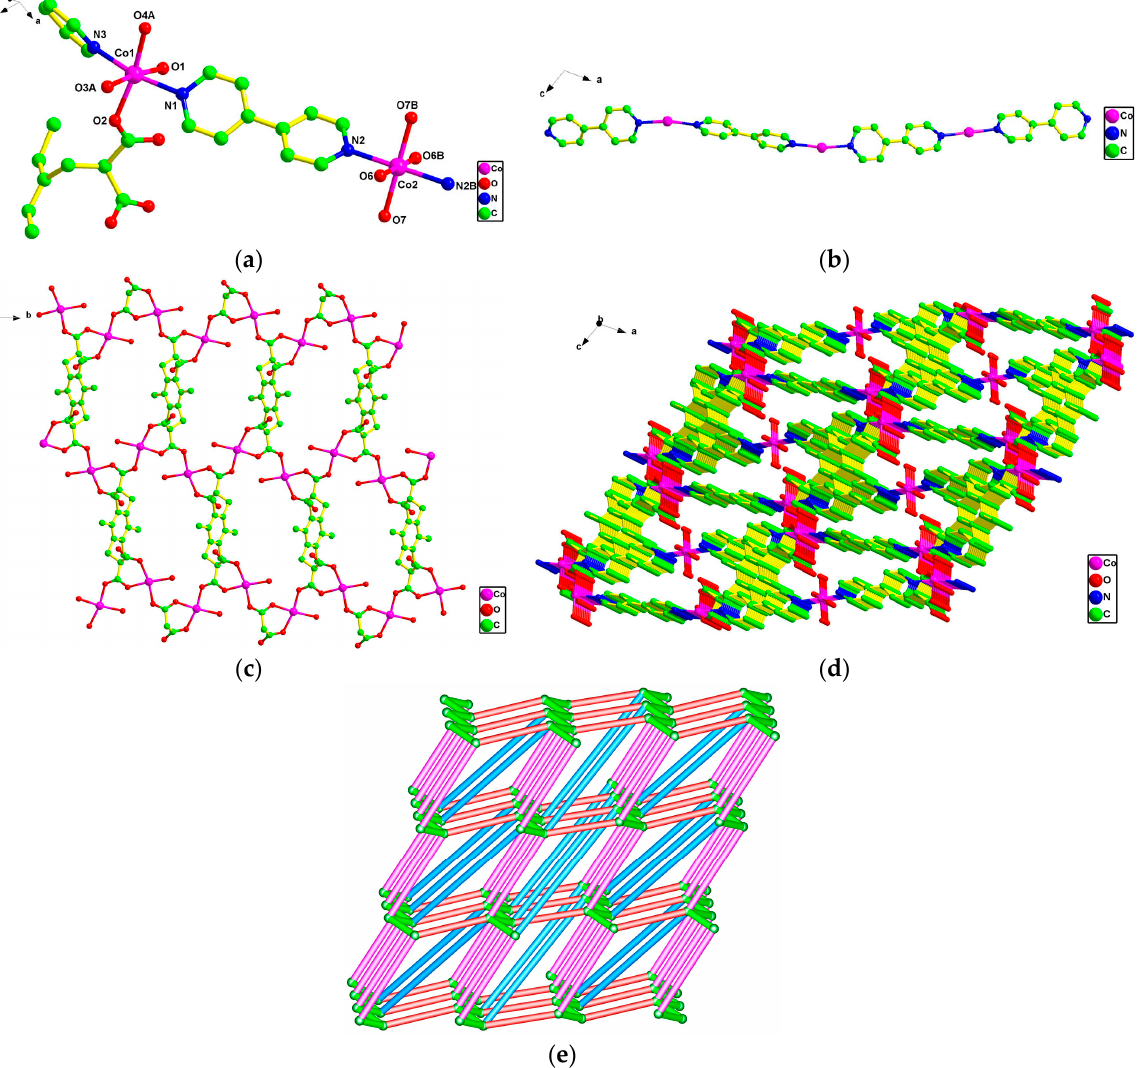
Figure 3. ( a ) Surrounding environment map of Co(II) in complex 3 , symmetric opcode: A = 0.5 − x, 0.5 + y, 0.5 − z; B = 1 − x, − y, − z. ( b ) Co(II)/4,4 ′ -bpy 1D chain. ( c ) Co(II)/Y 4 − 2D layer. ( d ) The 3D structure diagram of complex 3 . ( e ) Schematic view of the 3D topology network for 3 .